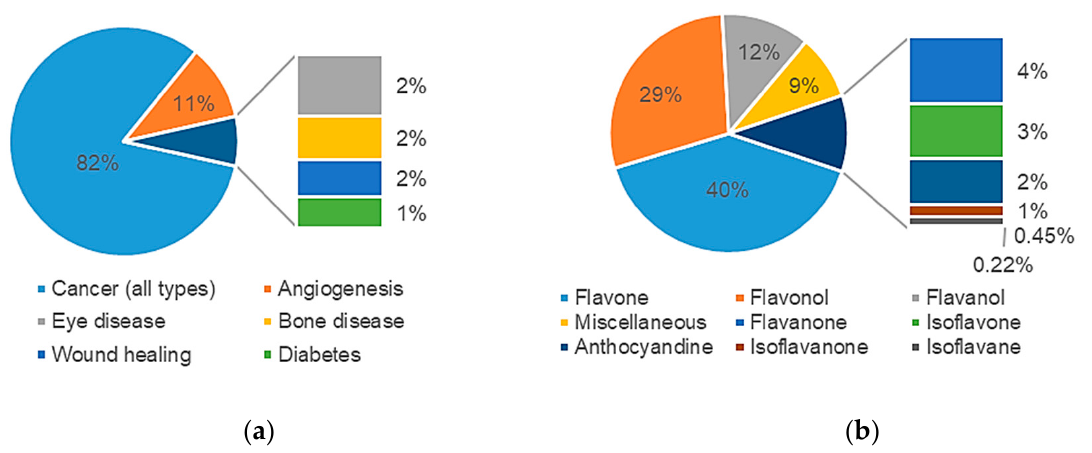
Figure 3. Profiling of papers retrieved in Section 1 with respect to: ( a ) pathology type; ( b ) chemical class of flavonoid.